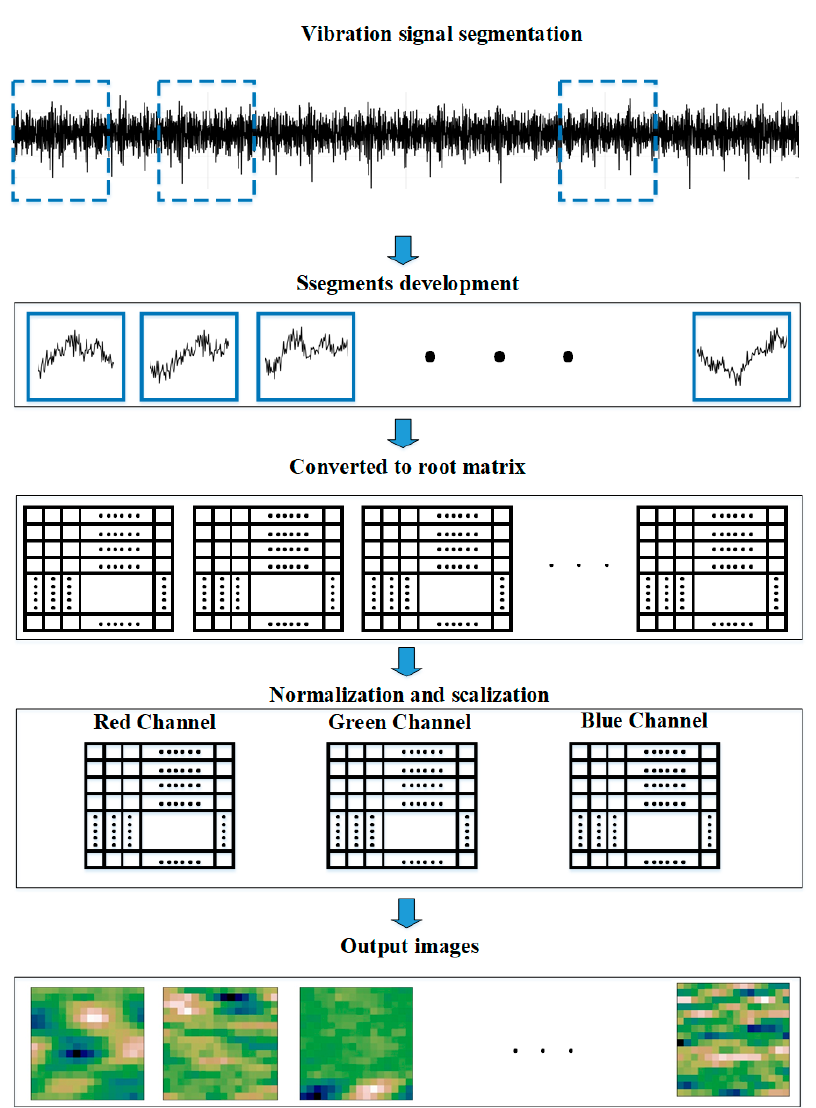
Figure 4. 1D signal to image conversion.